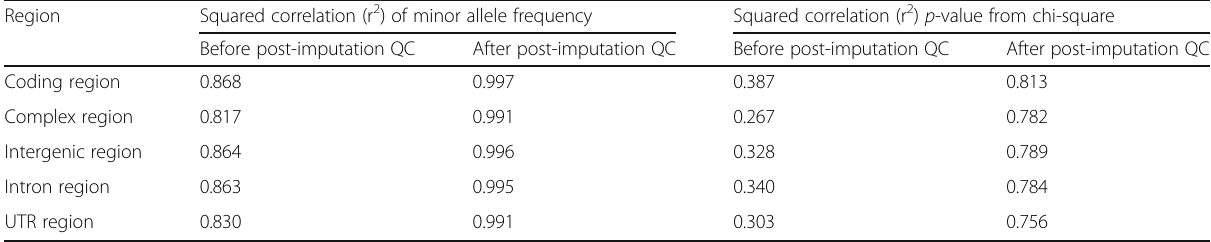
Table 1 Squared correlation of allele frequencies and chi-square P- values from SNPs in different regions Region Squared correlation (r 2 ) of minor allele frequency Squared correlation (r 2 ) p -value from chi-square Before post-imputation QC After post-imputation QC Before post-imputation QC After post-imputation